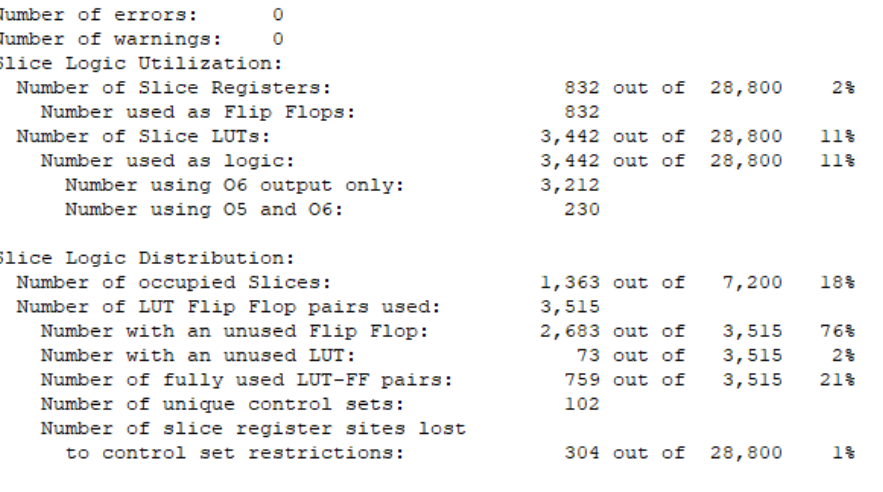
Figure 11. Implementation of the GFRX algorithm on FPGA.